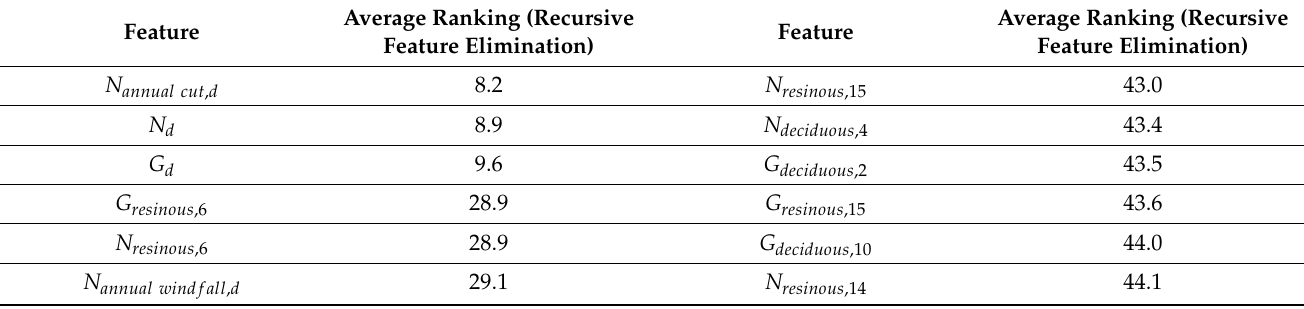
Table A1. Average ranking of features through Recursive Feature Elimination (one feature is elim- inated at each iteration until complete elimination of all features); these results are based on the optimal features transformation and the optimal regressor presented in Section 3.1.2; each average is calculated over feature ranks of the respective models for the 16 different diameter classes and over 10 train-test splits for each model (i.e., 160 values in